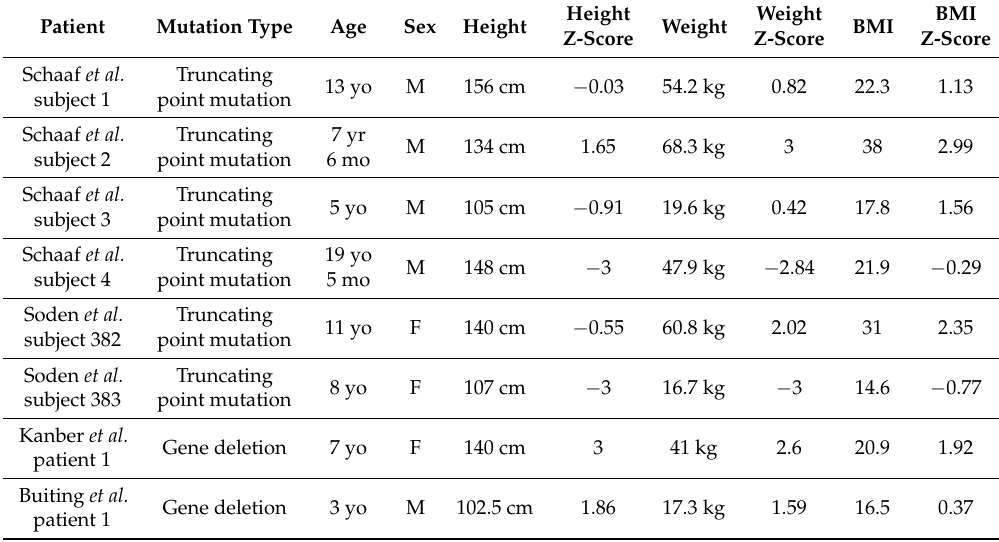
Table 1. Height, weight, and BMI of reported individuals with truncating point mutations or whole gene deletions of MAGEL2